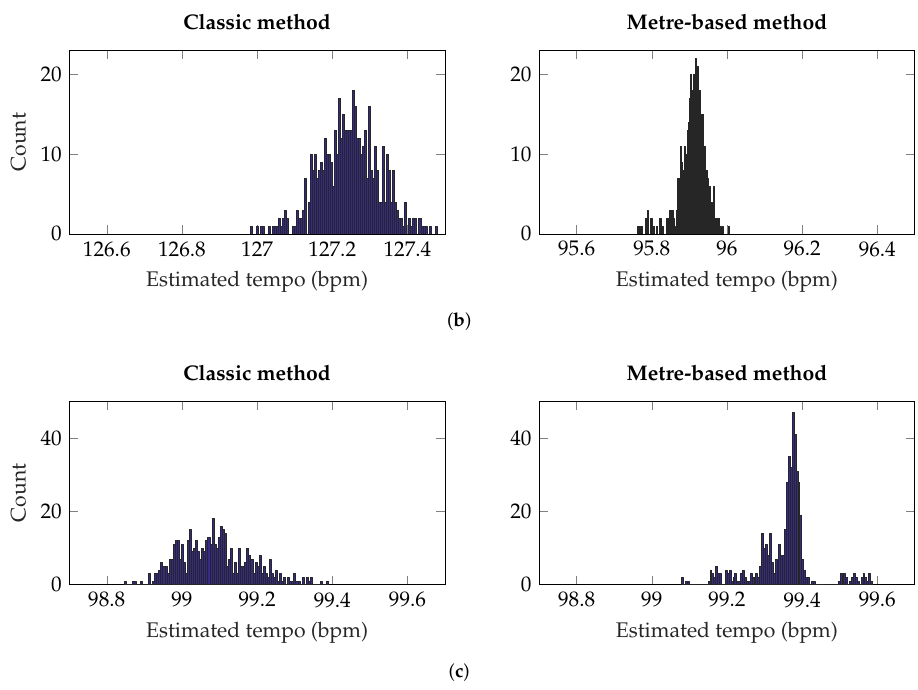
Figure 14. Estimated tempo for three songs, 500 mixes each using Equation (8). In each histogram, the data is split into 100 bins. Overall, performance is better for the metre-based method, as it demonstrates greater accuracy and improved robustness to changes in the mix; ( a ) “Burning Bridges”—The correct tempo is 100 bpm; ( b ) “I’m Alright”—The correct tempo is 96 bpm; ( c ) “What I Want”—The correct tempo is 99 bpm.